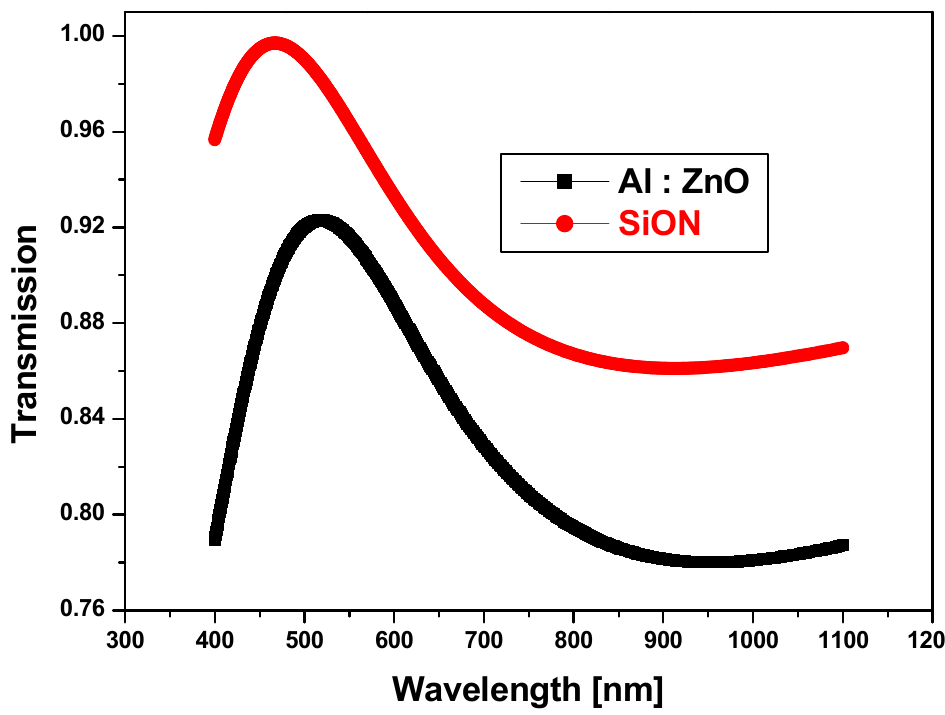
Figure 3. Transmission spectrum of 1D ternary PCs for one period with different embedded materials.